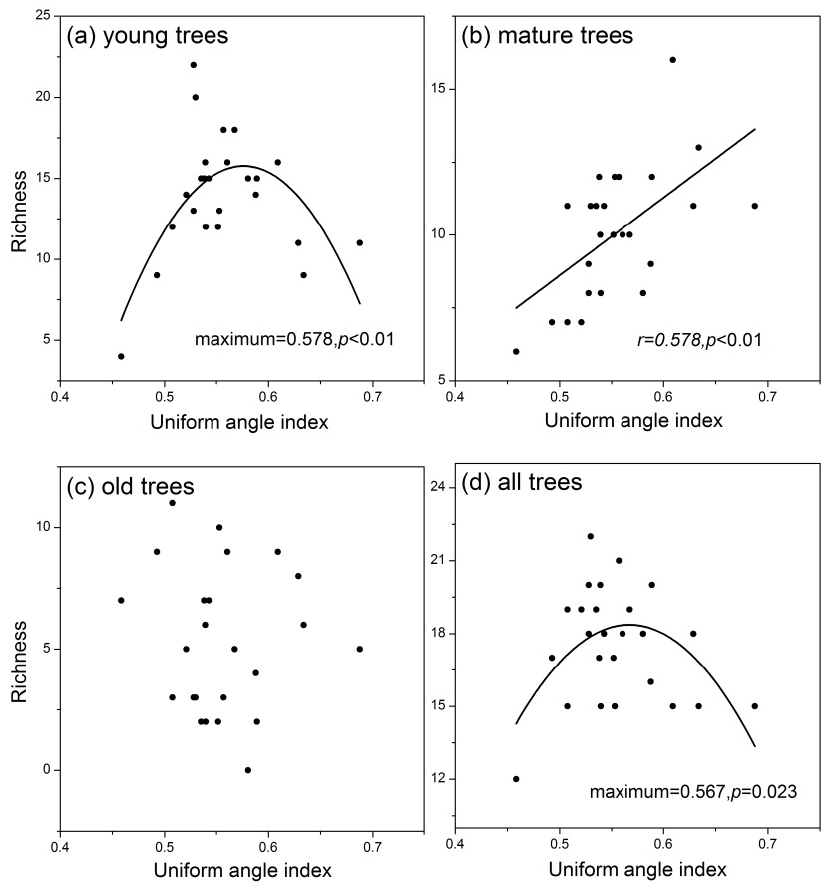
Figure 4. Relationship between the tree species richness and the spatial aggregation index of uniform angle index for all trees and different growth stages: ( a ) young trees; ( b ) mature trees; ( c ) old trees; ( d ) entire trees. If the relationship is significant ( p < 0.05), the regression line is plotted, with the unimodal relationship examined by the Mitchell ‐ Olds and Shaw (MOS) test.